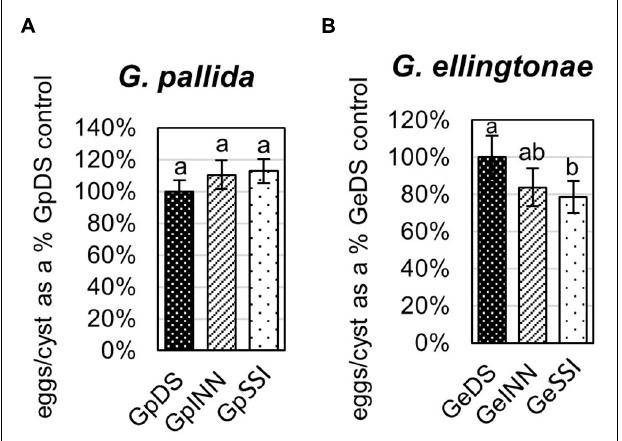
FIGURE 3 | The number of eggs/cyst for (A) Globodera pallida or (B) Globodera ellingtonae was measured as a percentage of value for a control DS hatching treatment (susceptible potato cv. Desirée) compared with resistant potato (cv. Innovator - INN), or immune plant ( S. sisymbriifolium - SSI). Each value represents the mean ± SE from bulking samples of three independent experiments. Means having the same letter designation are not significantly different as determined using ANOVA followed by Tukey’s HSD test at p <